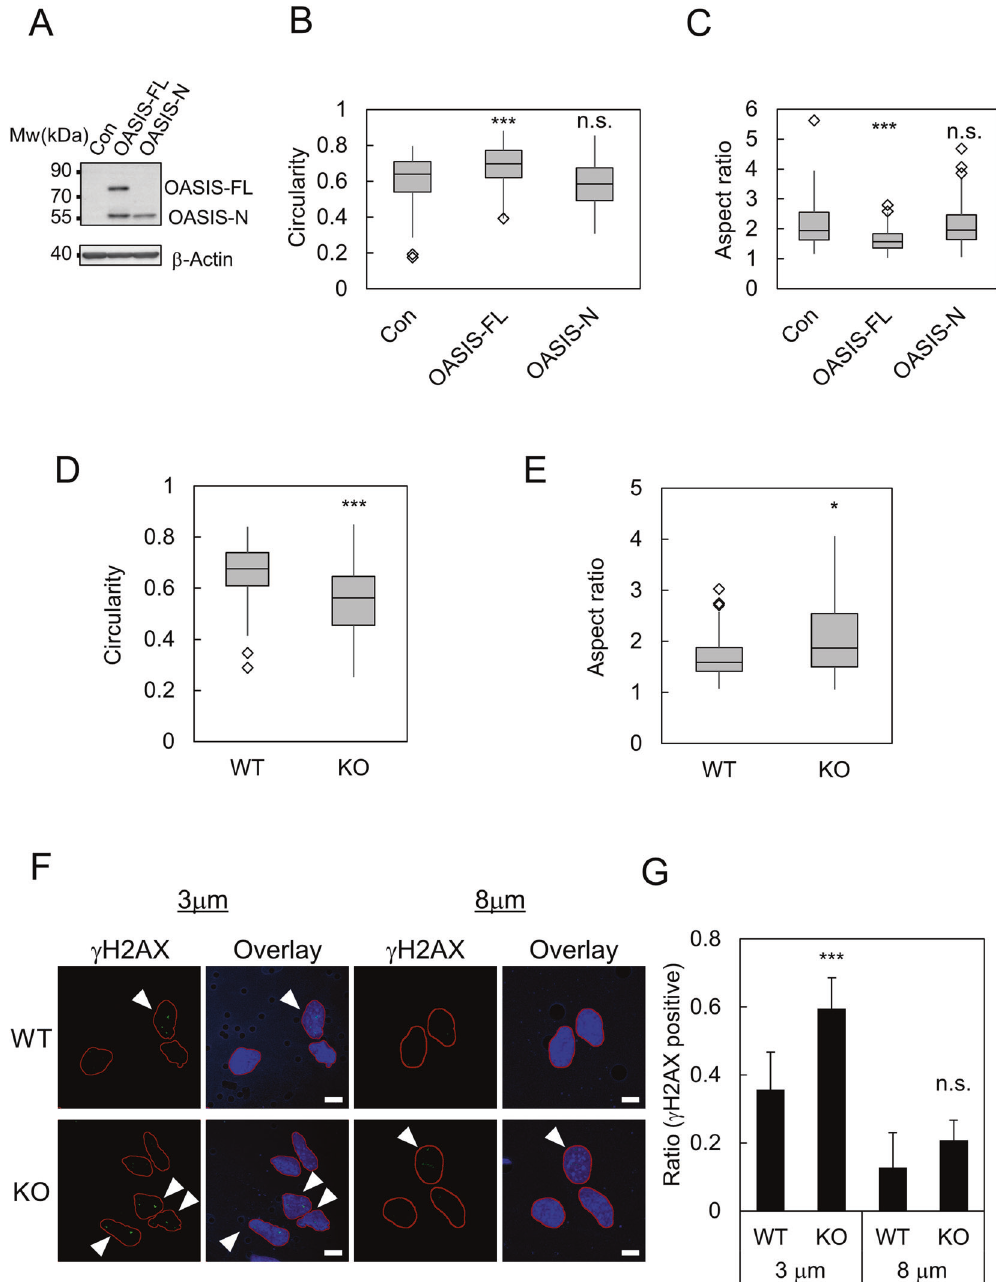
Fig. 6 OASIS suppresses DNA damage induced by NE stress and maintains nuclear morphology. A Western blot analysis of U251-Con (Con) cells, U251-OASIS-FL (OASIS-FL) cells and U251-OASIS-N (OASIS-N) cells. The expression of Flag-OASIS-FL and Flag-OASIS-N was con fi rmed using anti-Flag antibody. β -Actin was used as a loading control. B , C Quanti fi cation of ( B ) nuclear circularity and ( C ) nuclear aspect ratio of U251-Con cells (Con), U251-OASIS-FL (OASIS-FL) cells, and U251-OASIS-N (OASIS-N) at the bottom side of a Transwell. Box plots represent the medians and interquartile ranges with Tukey-style whiskers. Statistical signi fi cance of the differences was determined using Mann – Whitney U -test. *** p < 0.005. n.s. p > 0.05. n = 64 Con, n = 45 OASIS-FL, and n = 43 OASIS-N from three independent experiments. D , E Quanti fi cation of ( D ) nuclear circularity and ( E ) nuclear aspect ratio of wild type (WT) and Oasis knockout (KO) primary astrocytes at the bottom side of a Transwell. Box plots represent the medians and interquartile ranges with Tukey-style whiskers. Statistical signi fi cance of the differences was determined using Mann – Whitney ’ s U -test. * p < 0.05. *** p < 0.005. n = 57 WT and KO from three independent experiments. F Immuno fl uorescent staining analysis of γ H2AX in wild type (WT) and Oasis KO (KO) astrocyte at the bottom side of a 3 and 8 μ m pore Transwell. The typical images of WT cells (upper panels) and KO cells (lower panels) were represented, respectively. Red lines indicated the boundaries of the nuclei. Arrow heads indicated γ H2AX positive cells. G Quanti fi cation of the ratio of cells with γ H2AX foci at the bottom side of a Transwell. Bars and error bars represent the mean values and SD from three (for 3 μ m pore Transwell) or two (for 8 μ m pore Transwell) independent experiments. Statistical signi fi cance of the differences was determined using Fisher ’ s exact test. *** p < 0.005. n.s. p > 0.05. n = 57 WT at 3 μ m pore, n = 38 WT at 8 μ m pore, n = 69 KO at 3 μ m pore, n = 34 KO at 8 μ m. Scale bars: 5 μ